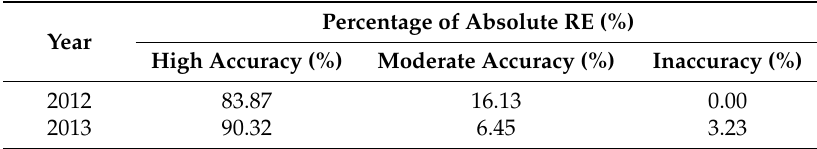
Table 3. Different categories of extension accuracies for TNL at the provincial